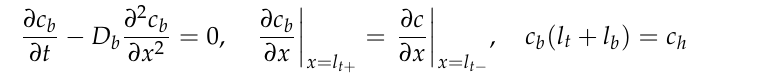
Figure 4. Schematic of mixing of the oxygen concentration AC perturbations 𝑐𝑐 ℎ1 due to the air flow in the channel. The perturbations 𝑐𝑐 ℎ1 produced upstream from the given segment are transported down the channel and sum up with the local perturbation. This interference affects local impedance. A custom parallel Python code was developed using the message passing interface library. Calculated segment impedance Z seg was fitted to the local experimental spectrum using the SciPy least-squares procedure least_squares with the method = ‘trf’ option [33]. The nine-pore model described above for each of the 10 segments requires 90 cores on a par- allel cluster. Detailed description of the parent whole-cell impedance model can be found in [25]. 3. Results and Discussion The local impedance spectra were measured at the operating conditions listed in Ta- ble 1. Figure 5 demonstrates experimental and fitted Nyquist spectra for the current den- sity of 400 and 800 mA cm −2 . Typical impedance spectra for a PEM fuel cell are represented by a semicircle at high-frequency, reflecting a charge transfer, proton and oxygen